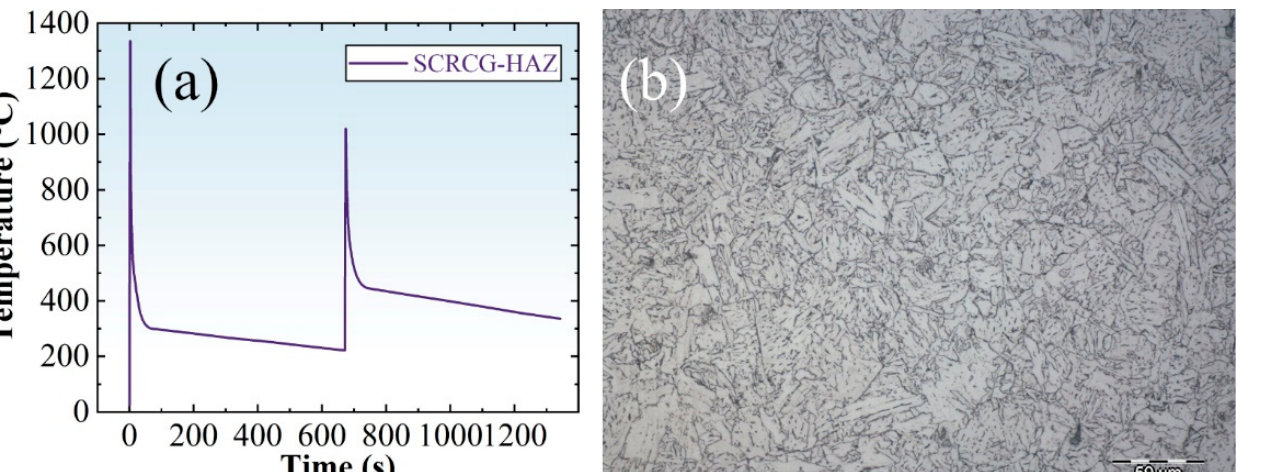
Figure 10. Thermal processes in zones with CG-HAZ processes during the last austenitized cycles and the thermal simulated microstructures (with a magnification of 1000): ( a ) thermal cycles calcu- lated for thermal simulation in CG-HAZs; ( b ) CG-HAZ1; ( c ) CG-HAZ2; ( d ) CG-HAZ3; ( e ) UACG- HAZ.